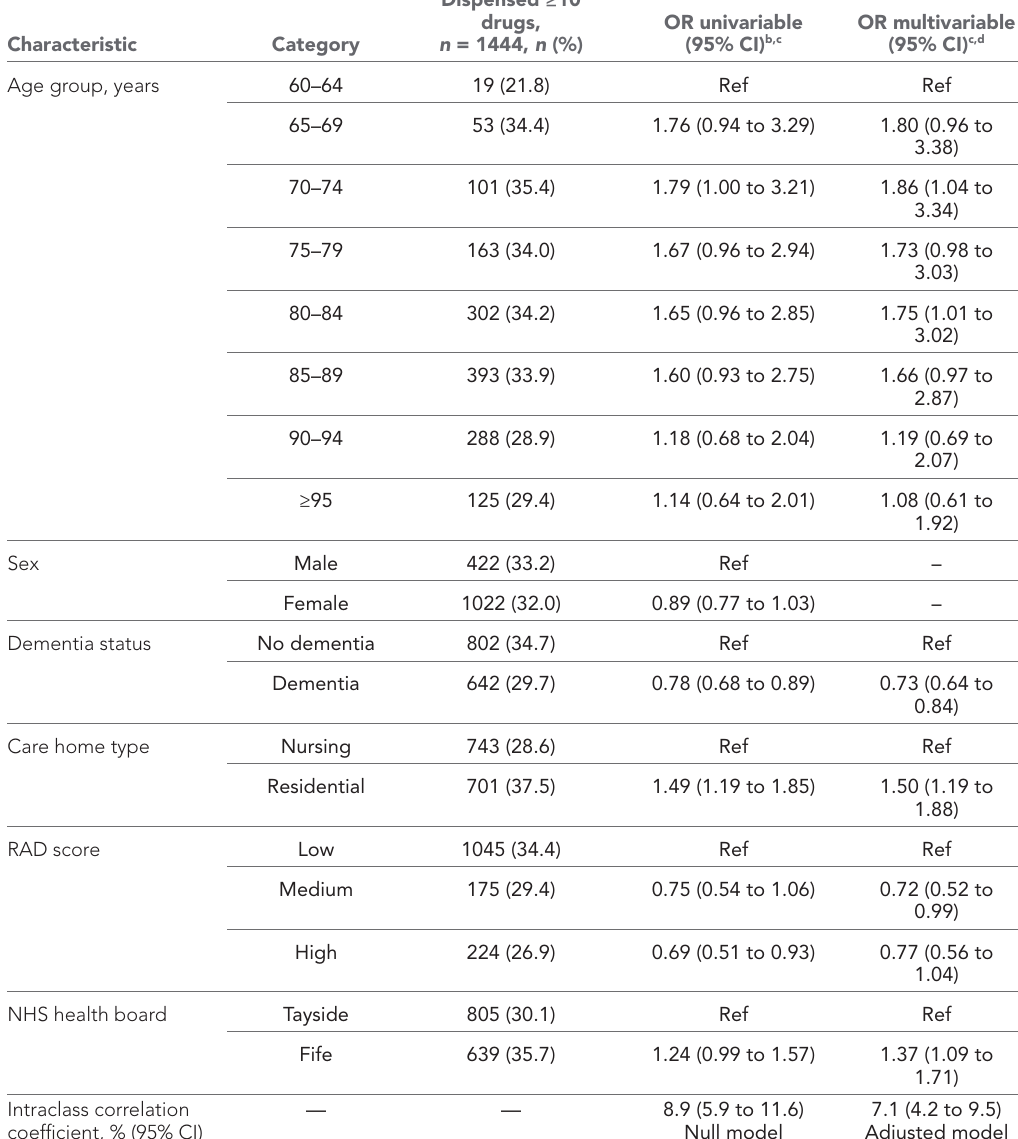
Table 3 Multilevel logistic regression analysis of excessive polypharmacy in care home residents